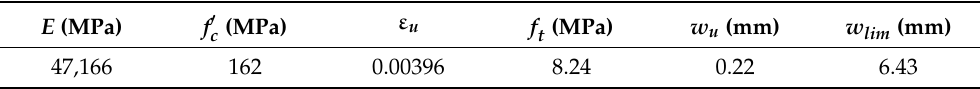
Table 5. Material properties based on test data from the literature